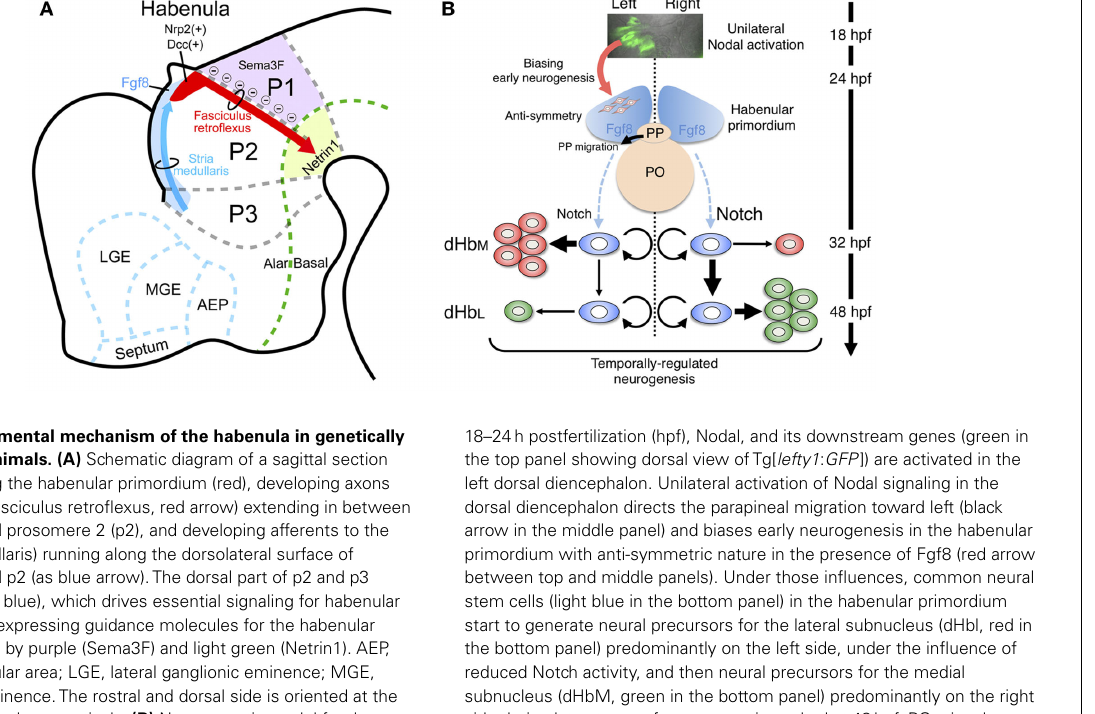
FIGURE 3 | Developmental mechanism of the habenula in genetically accessible model animals. (A) Schematic diagram of a sagittal section from E14 rat showing the habenular primordium (red), developing axons from the habenula (fasciculus retroflexus, red arrow) extending in between prosomere 1 (p1) and prosomere 2 (p2), and developing afferents to the habenula (stria medullaris) running along the dorsolateral surface of prosomere 3 (p3) and p2 (as blue arrow).The dorsal part of p2 and p3 expressed Fgf8 (light blue), which drives essential signaling for habenular development. Areas expressing guidance molecules for the habenular axons are designated by purple (Sema3F) and light green (Netrin1). AEP, anterior entopeduncular area; LGE, lateral ganglionic eminence; MGE, medial ganglionic eminence.The rostral and dorsal side is oriented at the left and top of the panel, respectively. (B) Neurogenetic model for the generation of left–right differences in the zebrafish dorsal habenula. At